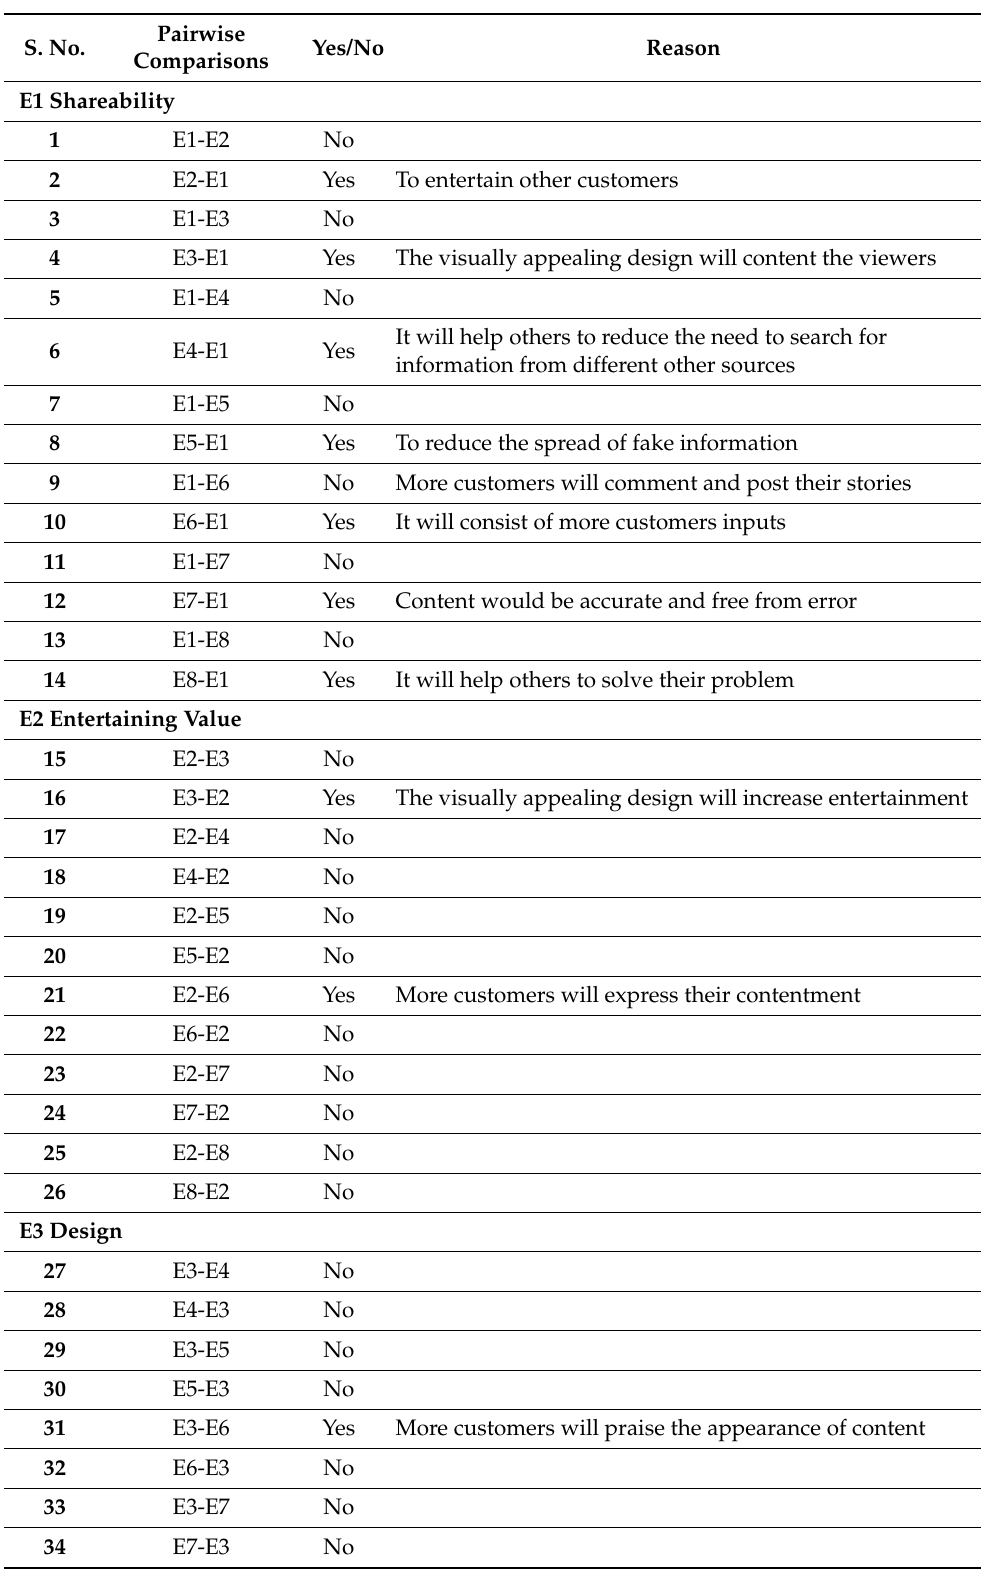
Table A1. Pairwise Comparison